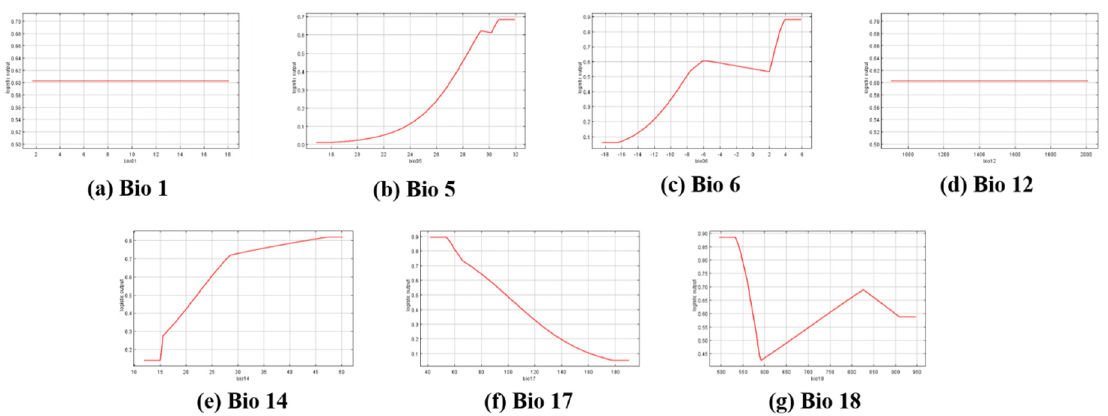
Figure 4. The response curves for each variable related to the presence of R. shantungensis in Korea: ( a ) Bio 1; ( b ) Bio 5; ( c ) Bio 6; ( d ) Bio 12; ( e ) Bio 14; ( f ) Bio 17; ( g ) Bio